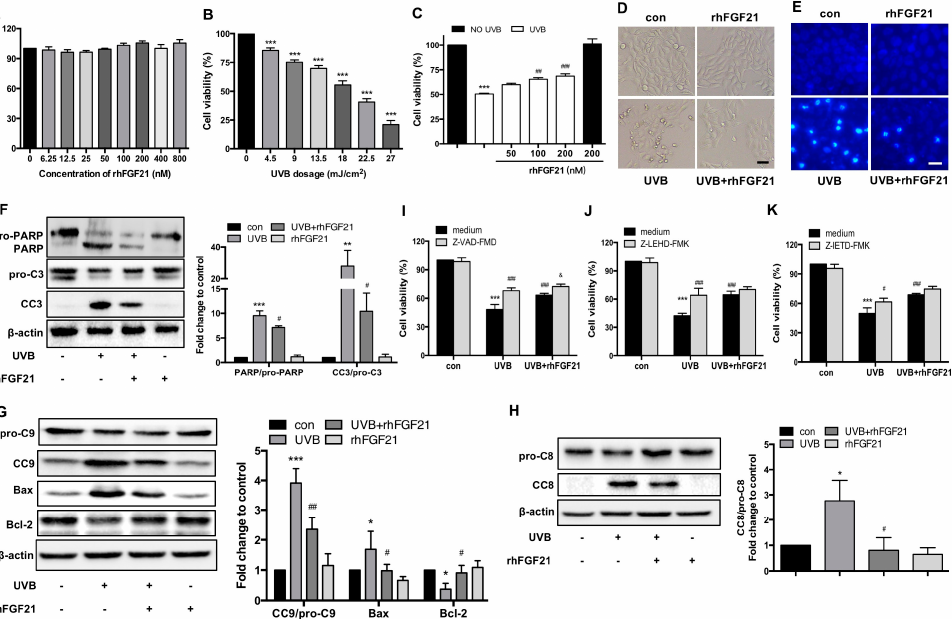
Figure 4. Treatment with rhFGF21 protects HaCaT cells from UVB-induced apoptosis. ( A ) The effect of rhFGF21 on HaCaT cell viability. Cell viability was assessed by MTT assay. ( B ) The effect of UVB on the viability of HaCaT cells. Cell viability was assessed by MTT assay. ( C ) The effect of rhFGF21 on the viability of UVB-irradiated HaCaT cells. Cell viability was assessed by MTT assay. ( D ) Morphological images observed by phase contrast microscopy. Scale bar = 50 µ m. ( E ) Fluorescence microscopic images of cells stained with Hoechst 33258. Scale bar = 25 µ m. ( F ) Western blot analysis of PARP, pro-caspase-3 (pro-C3) and active caspase-3 (CC3). Quantitative analysis of the intensity of PARP, pro-C3 and CC3. ( G , H ) The protein levels of pro-caspase-9, active caspase-9, Bax, Bcl-2, pro-caspase- 8 (pro-C8) and active caspase-8 (CC8) were detected and quantified by Western blot and ImageJ, respectively. ( I – K ) Viability of cells treated with Z-VAD, Z-LEHD and Z-IETD, respectively. Cell viability was evaluated by MTT assay. Data are the means ± SD of three independent experiments, * p < 0.05, ** p < 0.01, *** p < 0.001 versus HaCaT cells without UVB radiation exposure; # p < 0.05, ## p < 0.01, ### p < 0.001 versus UVB-irradiated HaCaT cells; & p < 0.05 versus rhFGF21-treated HaCaT cells injured by UVB